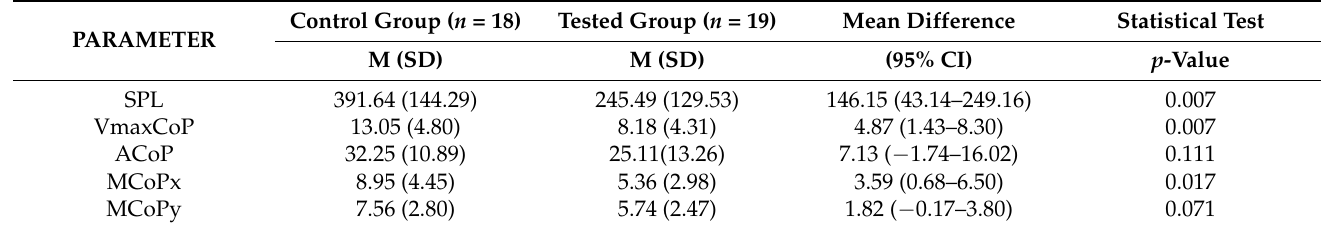
Table 4. Main center-of-pressure (CoP) parameters describing spontaneous sway of CoP in the prone position in the control group (infants presented normal fidgety movements) vs. the tested group (infants presented absent fidgety movements).